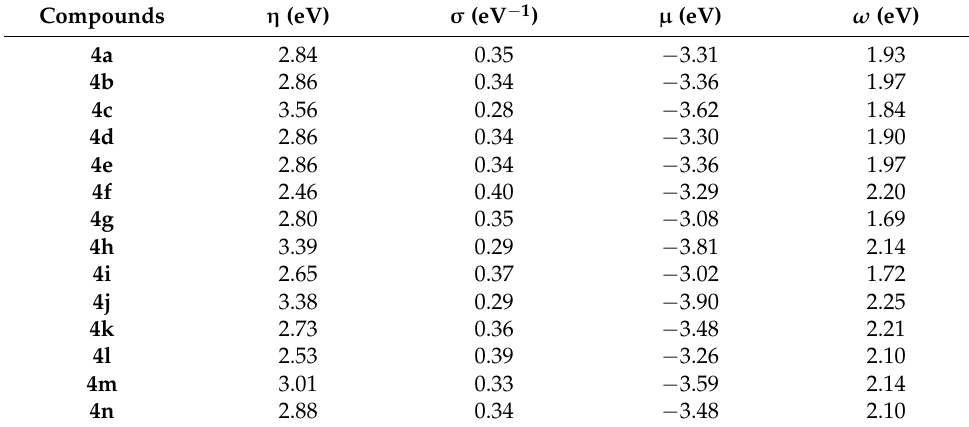
Table 4. Reactivity descriptors η , σ , µ and ω values of the final compounds 4a – 4n .